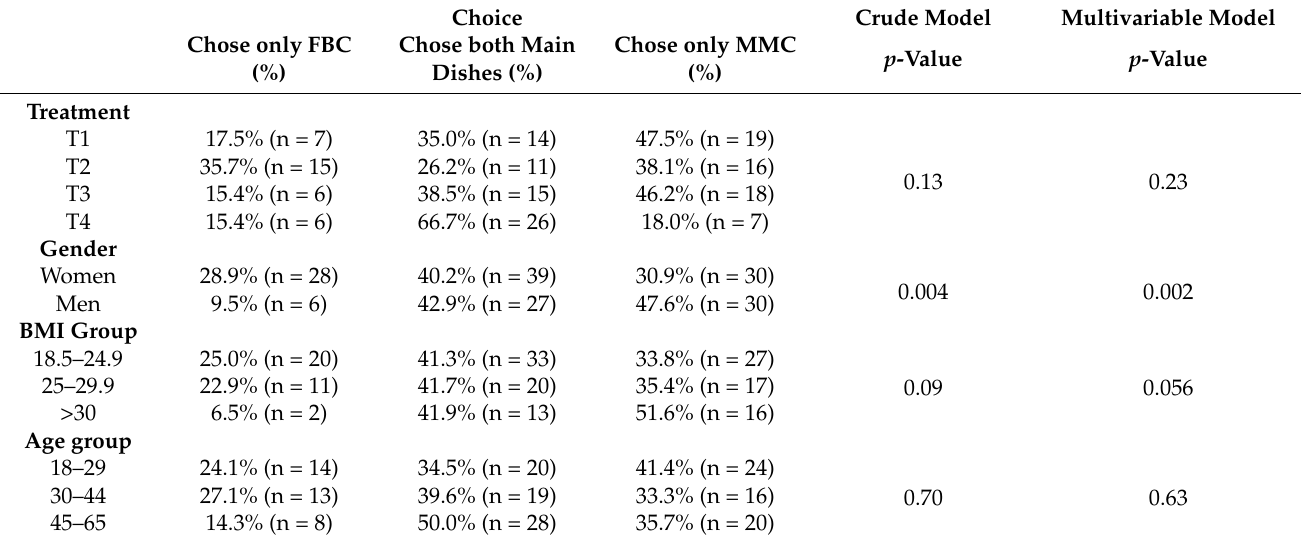
Table 3. Main dish choices by treatment, gender, body mass index (BMI) group, and age group. Analyses were conducted using ordinal logistic regression.